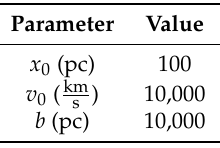
Figure 3. Numerical solution as given by Equation (32) (full line) and asymptotic solution as given by Equation (35) (dashed line), with parameters as in Table 1. Table 1. Parameters for a classical extra-galactic